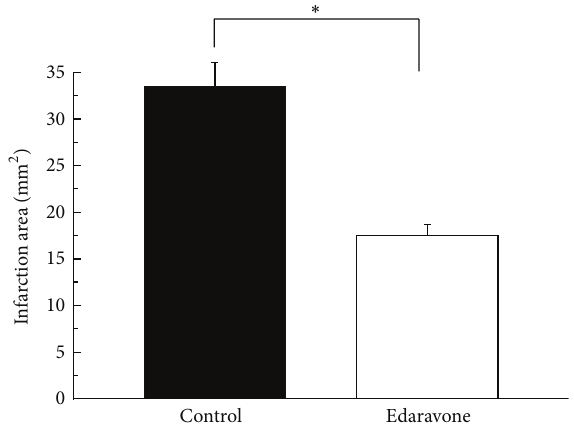
Figure 3: Functional recovery from photochemical infarction. The closed circles indicate the edaravone-treated group, and the open circles indicate the control group ( ∗ 𝑃 < 0.05 , ∗∗ 𝑃 < 0.01